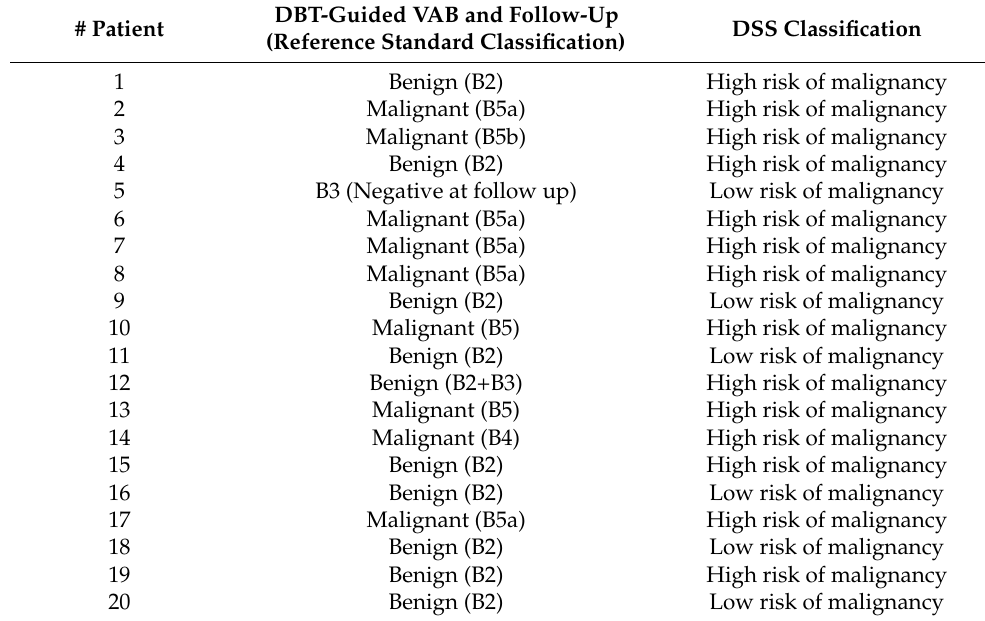
Table 7. Reference standard classification (from DBT-guided VAB and follow-up, and DSS classifica- tion, for each single patient included in the